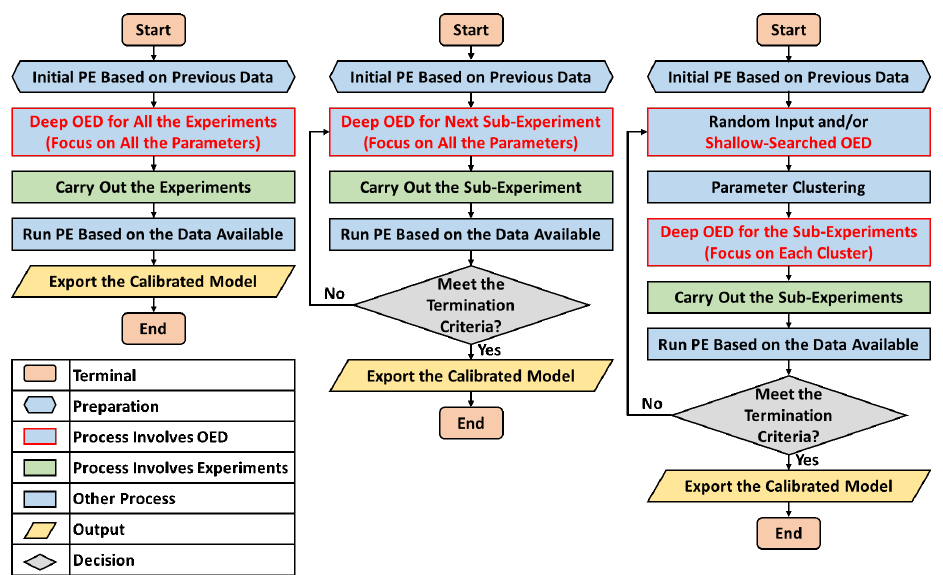
Figure 4. Flow charts of the off-line OED ( left ), on-line OED ( middle ), and cluster-based OED ( right